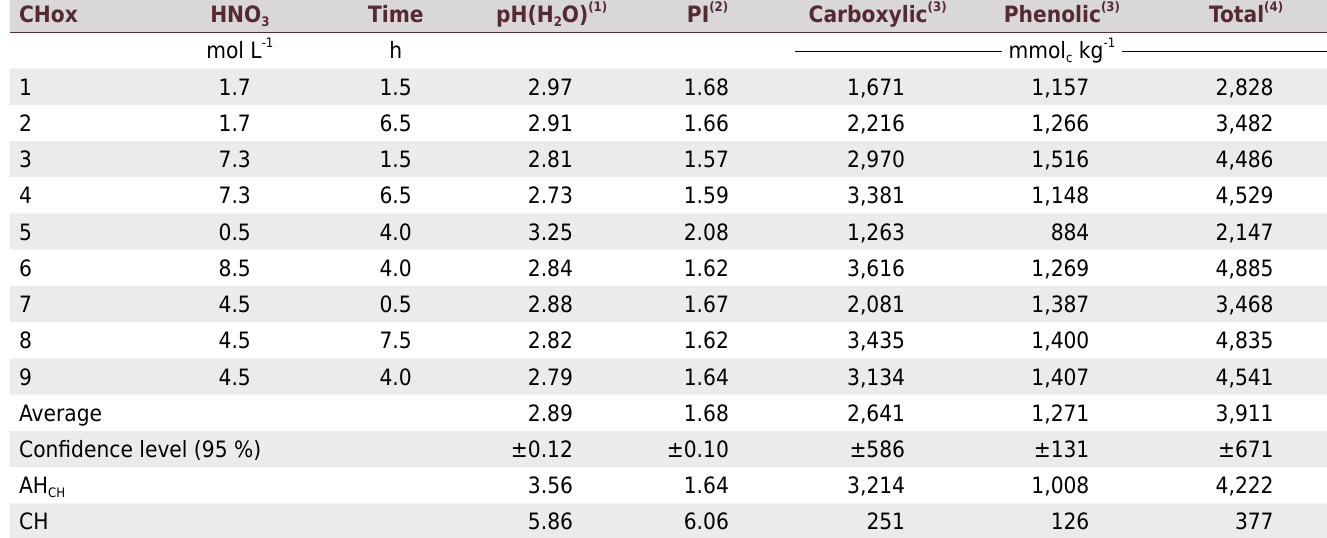
Table 2. Isoelectronic points (PI), pH values in water, quantity of carboxylic groups, phenolics, and total acidity values of the functionalized charcoals (CHox) obtained according to nitric acid concentration and reaction time of humic acid obtained from charcoal (AH CH ) and eucalyptus charcoal (CH) CHox